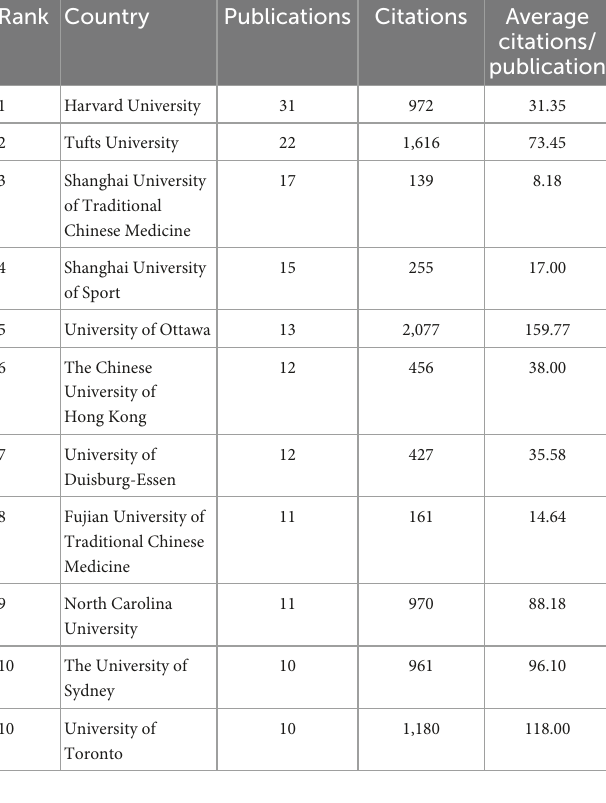
TABLE 4 Top 10 Institutions with the highest frequency of traditional Chinese exercises for musculoskeletal disorders.